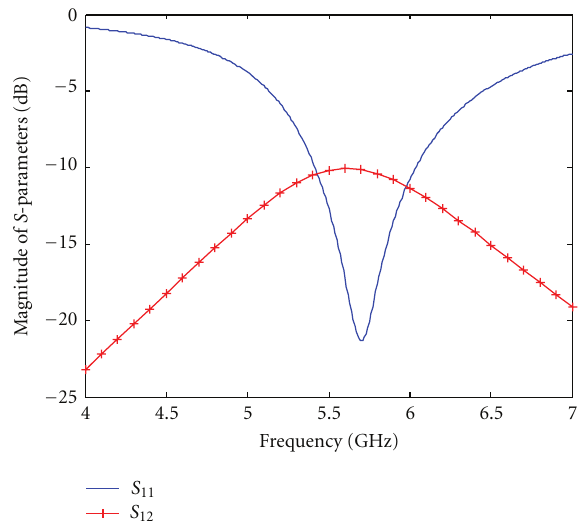
Figure 5: Simulated magnitudes of S 11 and S 12 of array no. 1.